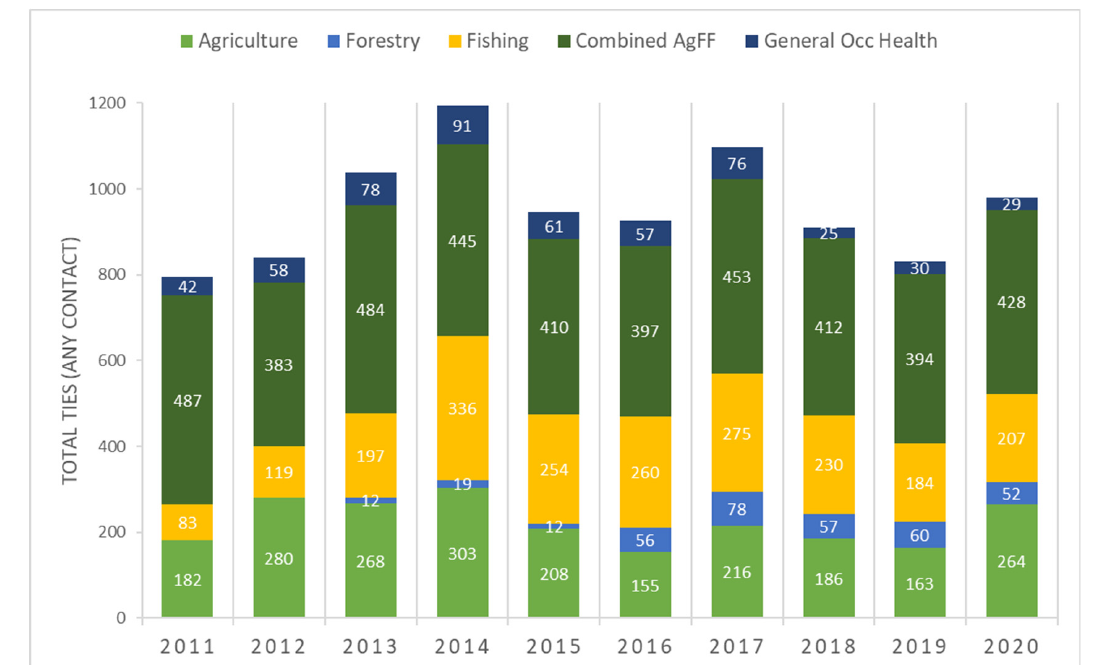
Figure 2. Total number of ties and distribution of ties by sector, 2011–2020. Table 6. Degree centrality measures of the NEC network over ten years (IQR = interquartile